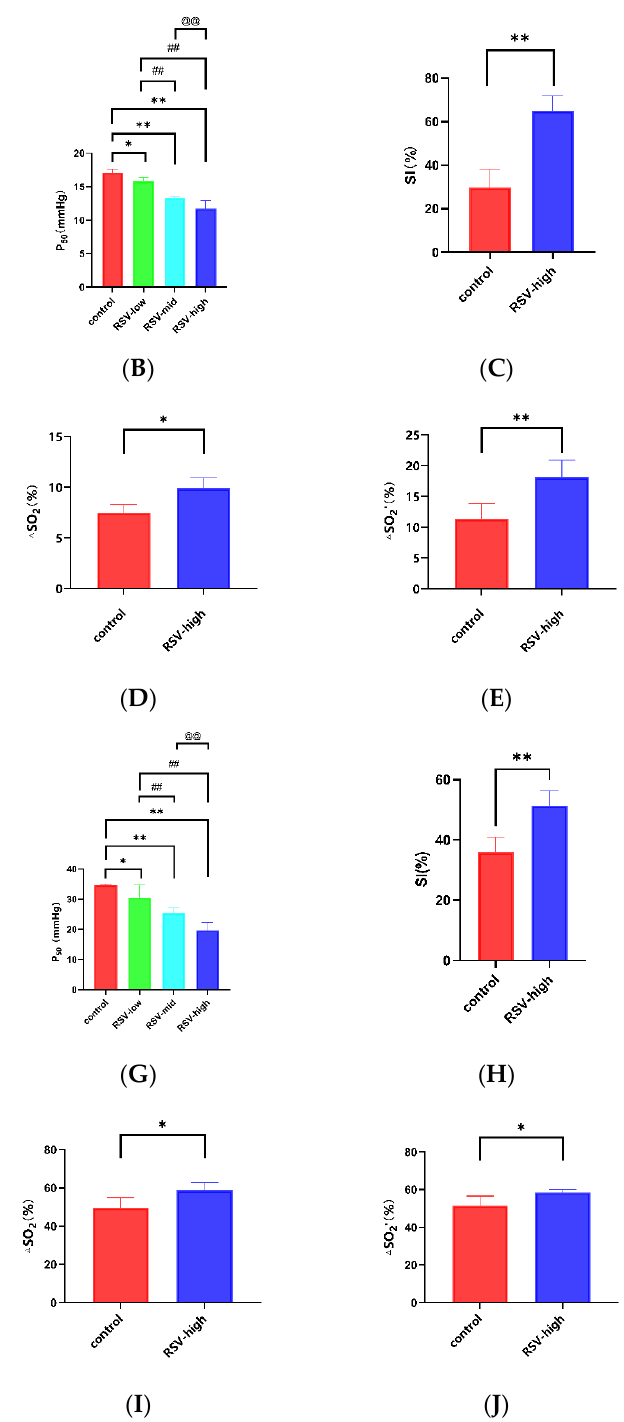
Figure 3. The oxygen supply efficiency of HbA and rat RBCs with RSV ex vivo. Oxygen dissociation curves of ( A ) HbA and ( F ) rat RBCs with different concentrations of RSV: P 50 values of ( B ) HbA and ( G ) rat RBCs with different concentrations of RSV; SI values of ( C ) HbA and ( H ) and rat RBCs with different concentrations of RSV; ∆ SO 2 values after the modification of ( D ) HbA and ( I ) rat RBCs with different concentrations of RSV; ∆ SO 2 ′ values after the modification of ( E ) HbA and ( J ) rat RBCs with different concentrations of RSV. Note: *, vs. control, p < 0.05; **, vs. control, p < 0.01; ##, vs. RSV-low, p < 0.01; @@, vs. RSV-mid, p < 0.01.